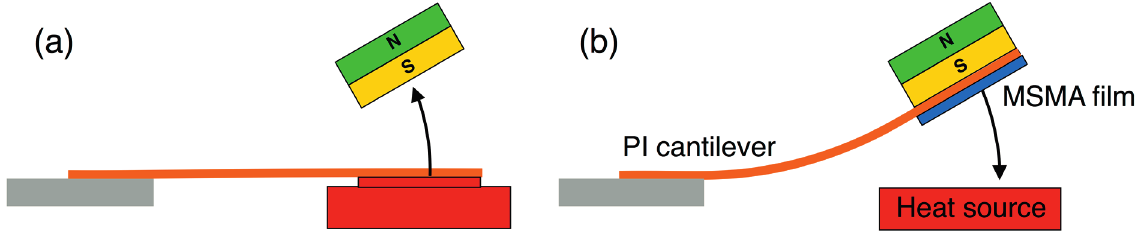
Figure 18. Operation principle of thermomagnetic actuation. The system consists of a polyimide (PI) cantilever fixed on a substrate, a stack of metamagnetic SMA films at the freely movable cantilever end, a magnet and a heat source. ( a ) A magnetostatic attraction force occurs due to phase transformation to ferromagnetic austenite while in contact to the heat source; ( b ) The elastic reset force dominates after cooling to nonmagnetic martensite. Adapted from